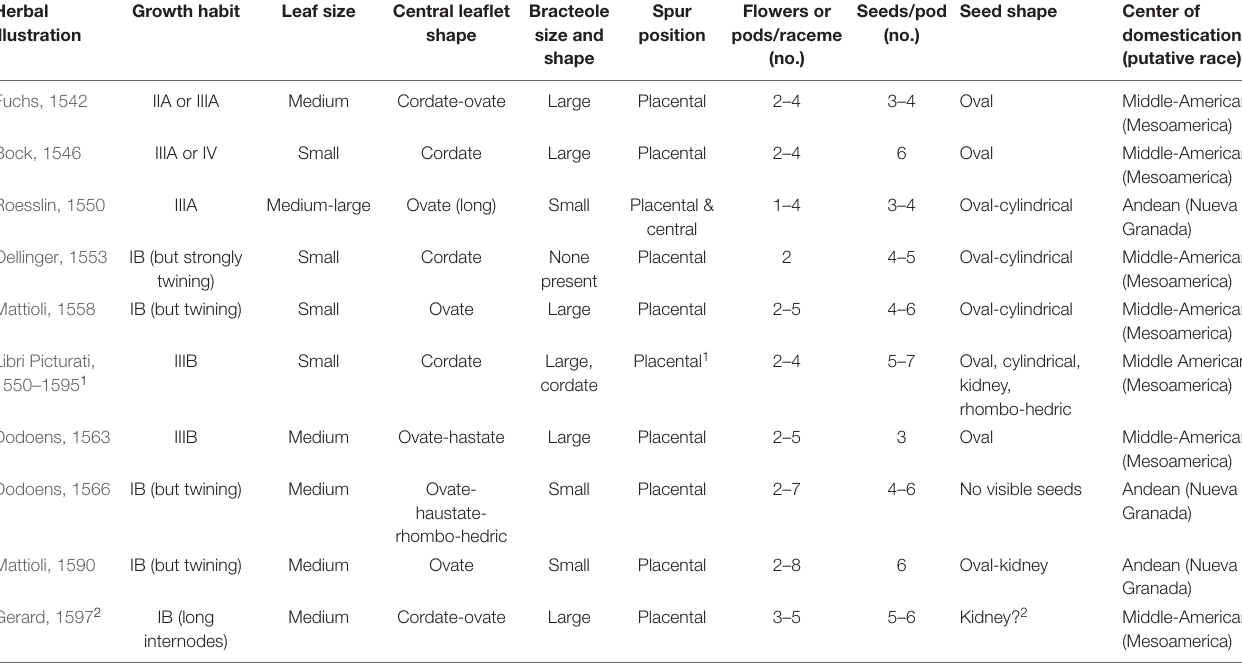
TABLE 4 | Comparison of early common bean herbal illustrations for traits associated with centers of domestication and races of common bean. Herbal Growth habit Leaf size Central leaflet illustration